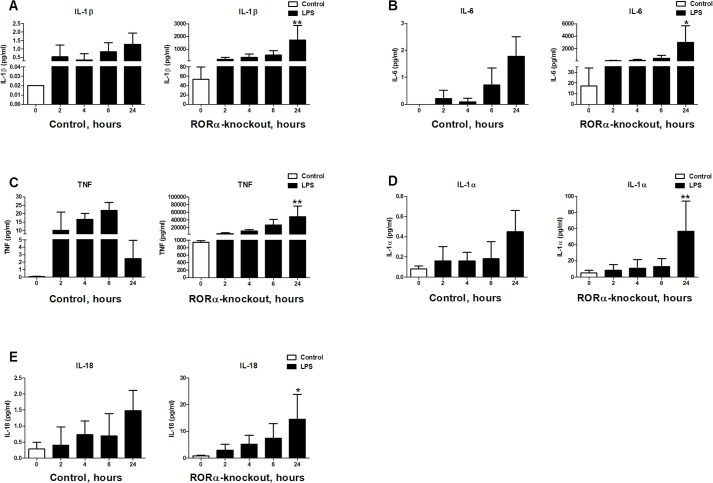
Cytokine secretion by RORA knockout cells.Deletion of RORA led to increase in basal and LPS-induced cytokine secretion. A. IL-1β has the biggest increase of approximately 2500 folds, B. IL-6 levels increases nearly 15 folds, C. TNF levels increases almost 900 folds, D. IL-1α levels increases approximately 50 folds and E. IL-18 levels increases 5 folds in deletion cells. 2.5×105 cells in 24-well plates were differentiated using 50 ng/ml PMA for 48 hours. Stimulation was performed after 24 hours of rest in PMA-free media with 10 ng/ml LPS for 2, 4, 6 and 24 hours. Cytokines quantification was performed using multiplex cytokine assay on the supernatant. Graphs are representatives for at least three independent experiments. Statistical analysis was calculated using ANOVA test. Stars indicate significance of differences between control and knockout cells after post hoc Bonferroni correction.